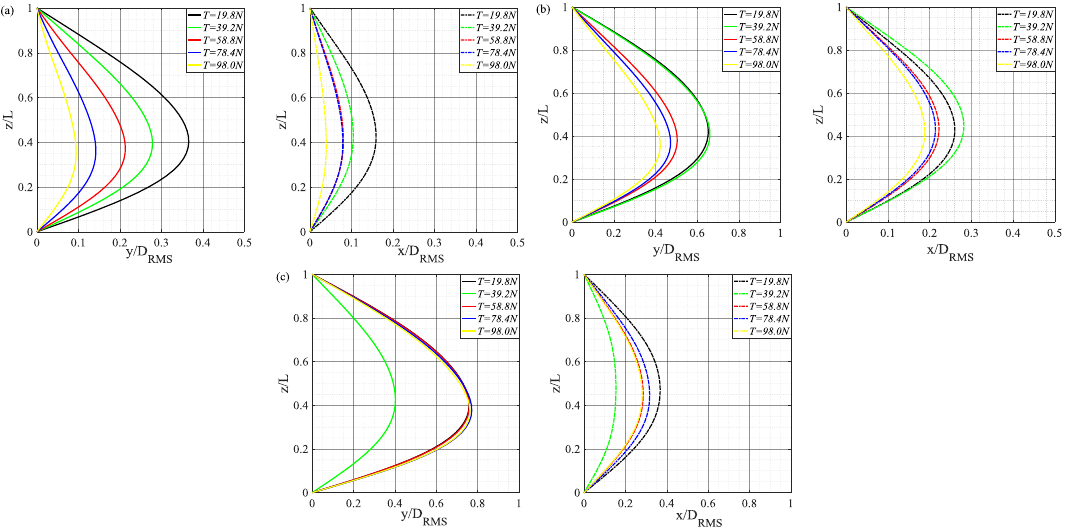
Figure 11. Cross-flow and in-line riser RMS displacements curves along the length of the riser at U = 0.3 m/s ( a ), U = 0.45 m/s ( b ), U = 0.6 m/s ( c ) under different top tensions.